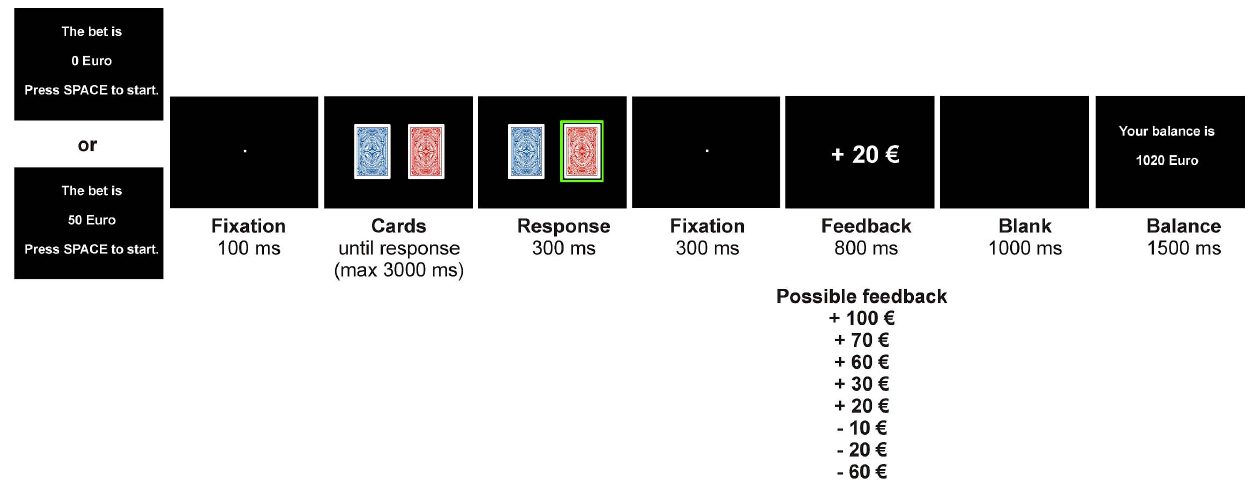
Figure 1. Schematic timeline of stimulus presentation in the gambling task. Participants were informed about the bet at the beginning of each trial, then chose one of two cards by button press before feedback was presented. At the end of each trial, participants were informed about their current account balance.